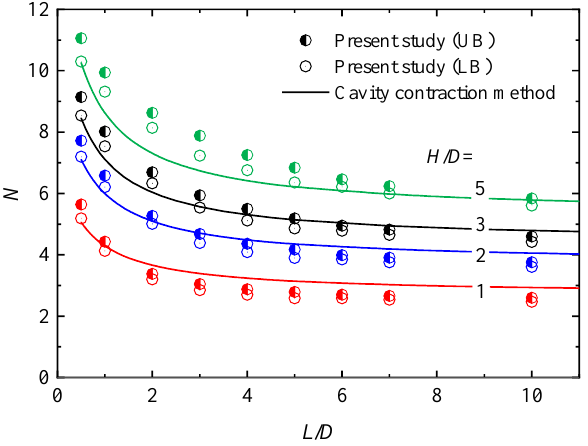
Figure 5. Comparison of predicted stability numbers with 3D FELA results.